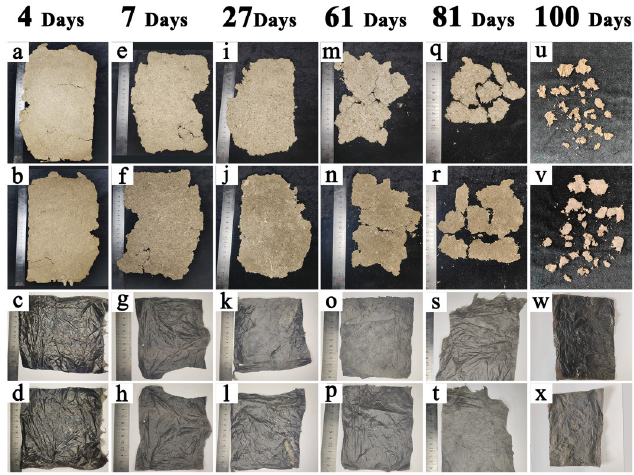
Fig 4. The degradations of CDLM and PE films at VS of ST, VE, V6, V18, R2 and R4 stages in